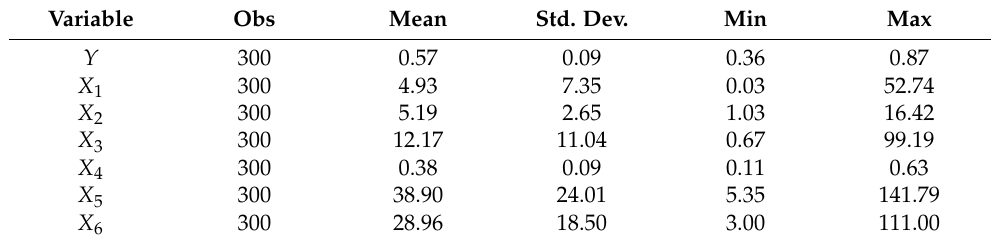
Table 8. Descriptive statistics of variables.